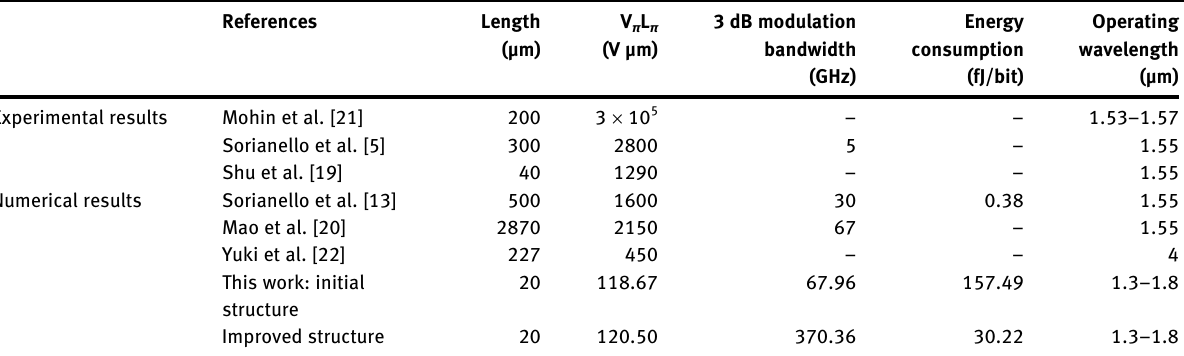
Table  : A comparison of some recent reported